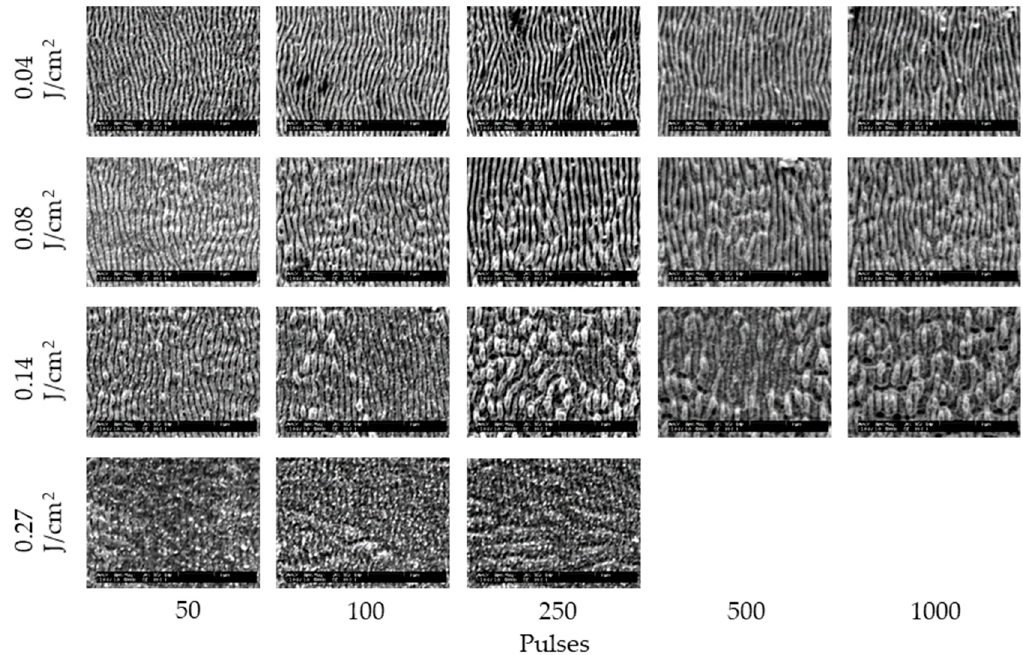
Figure 2. SEM images of 304 stainless steel irradiated with N = 50–1000 pulses at F = 0.04–0.27 J/cm 2 under air. The laser beam has the polarization in a lateral direction.